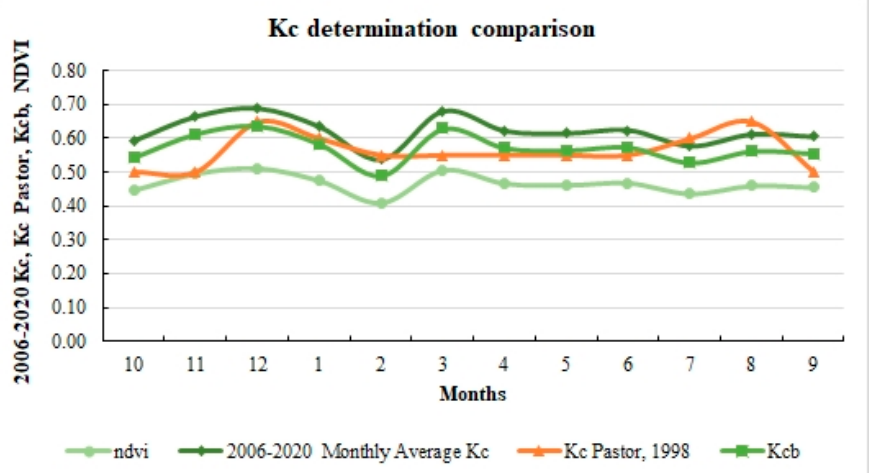
Figure 7. Average monthly values of NDVI and Kc. (All Kc and NDVI values are dimensionless. Kc Pastor [105]).